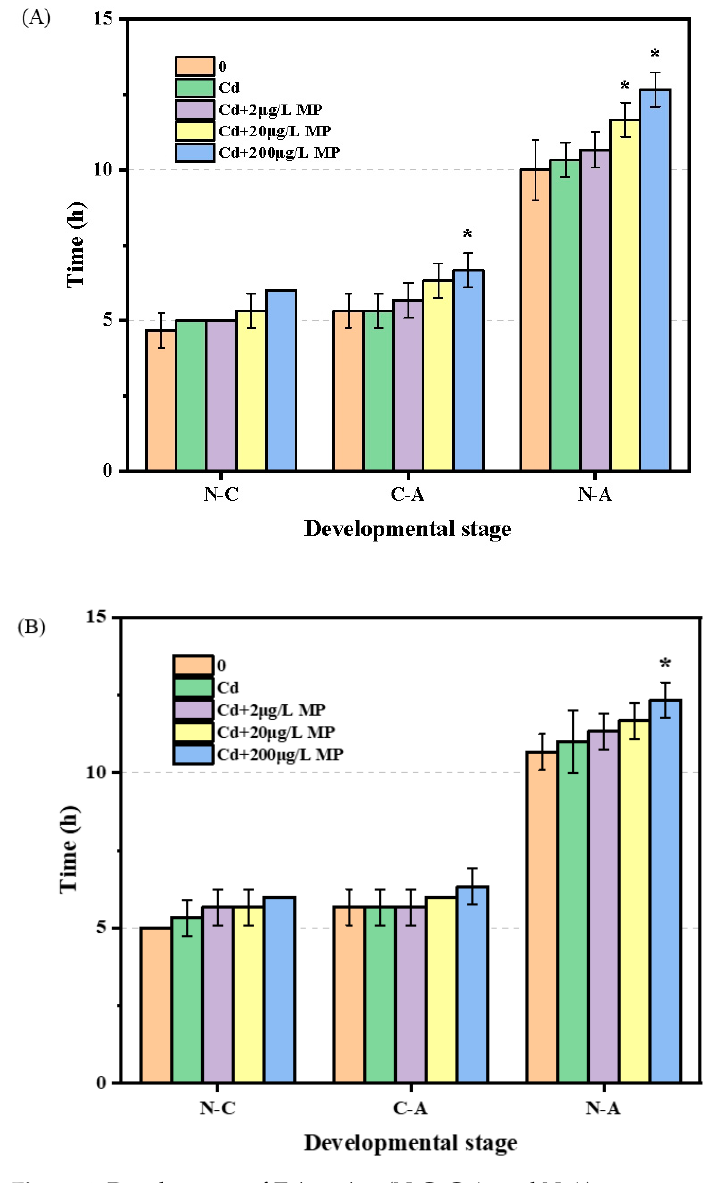
Figure 4. Development of T. japonicas (N-C, C-A, and N-A) exposure to Cd and microplastic. ( A ) F1 generation and ( B ) F2 generation. Significant differences between the exposure and controlled groups are marked with * ( p < 0.05).